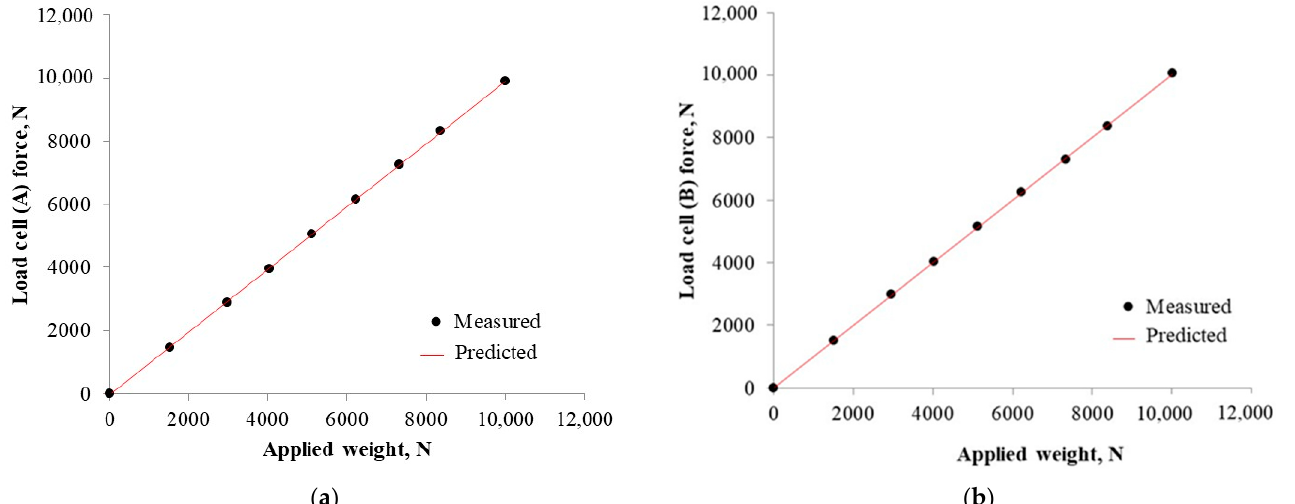
Figure 13. Results of calibration tests relating the output data on the load cell: ( a ) A; ( b ) B.